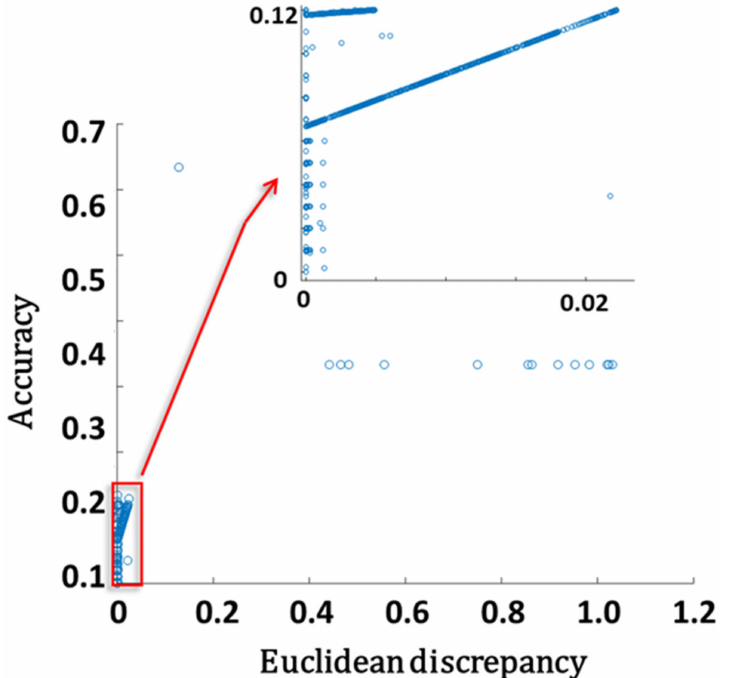
Figure A2. The computed accuracy ( Ψ Err ) vs. the Euclidian discrepancy using a high-end detector array when source #5 is leaking at a rate of 2.5 kg/s. The upper part shows an enlargement of the accurate solution region as marked by the red